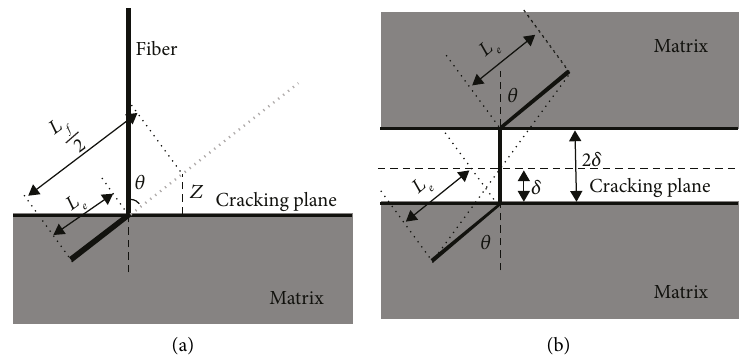
Figure 3: The sketch of fiber bridging crack [17]. (a) Single-side pullout model and (b) two-side pullout